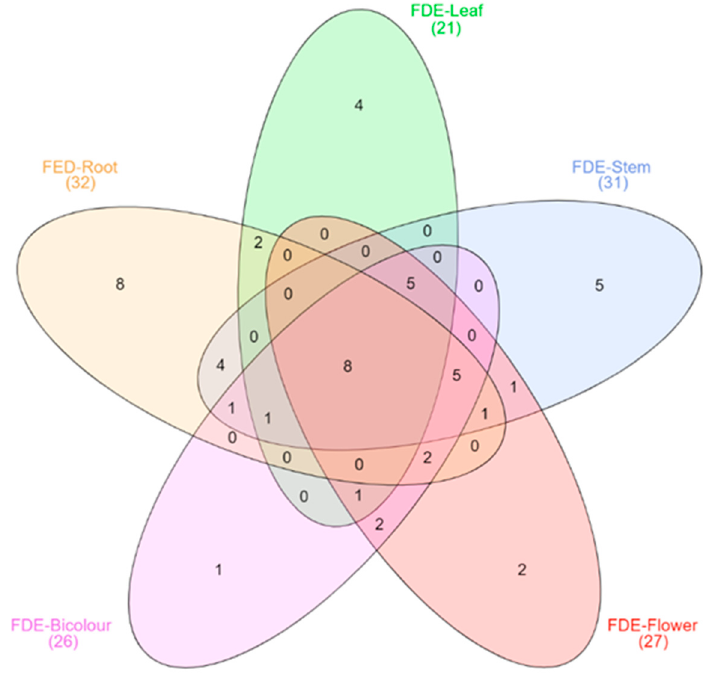
Figure 2. Venn diagram showing the volatile and semi-volatile compounds unique and shared between the FDEs of Pelargonium peltatum .